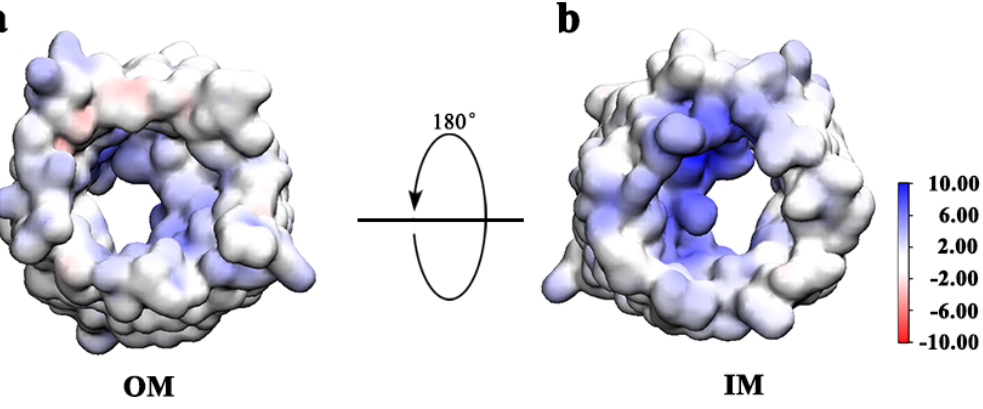
Figure 7. The electrostatic surface potential of hVDAC1 seen from OM side ( a ) and IM side ( b ). It is calculated using the Adaptive Poisson–Boltzmann Solver, APBS.